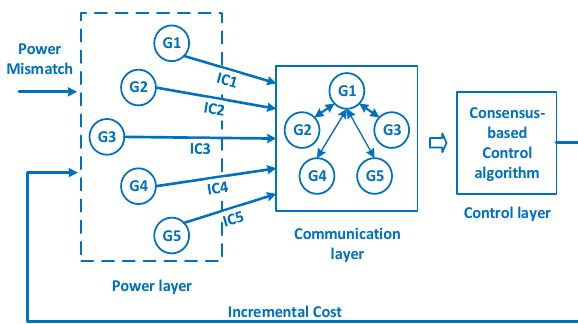
Figure 1. The simulation model of a five-generator smart grid, in which three main layers are indicated, five generators are modelled in power layer;